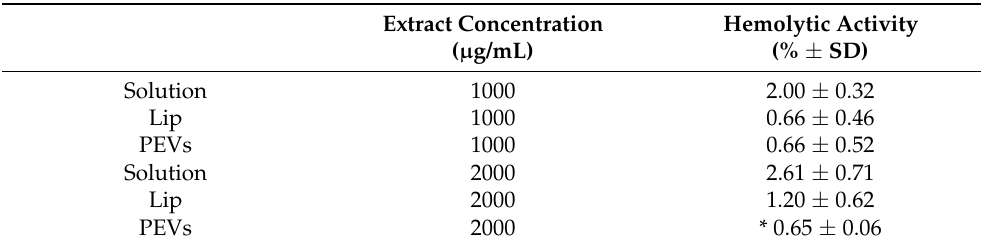
Table 8. Hemolytic activity of P. spinosa fruit extract in solution and in the nanoformulations. Data are expressed as % means ± standard deviations (SD); n =